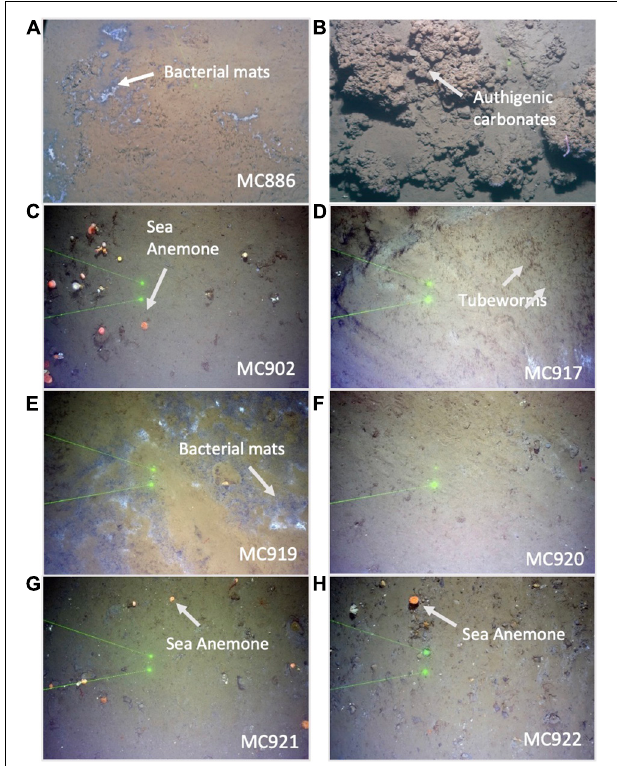
FIGURE 2 | Seafloor images from the Vestnesa Ridge MC886 Lunde pockmark, MC893 Lomvi pockmark showing gr a y bacterial mats (A) and authigenic carbonates (B) , and from Storfjordrenna pingos site from active site gas hydrate pingo 1 (GHP1; MC902—MC919) showing tubeworms (D) , gr a y bacterial mats (E) and sea anemones (C) , and from the inactive site GHP 5 (MC920—MC922) showing sea anemones (G,H) . Distance between laser dots (green dots) = 20 cm. (F) regular marine